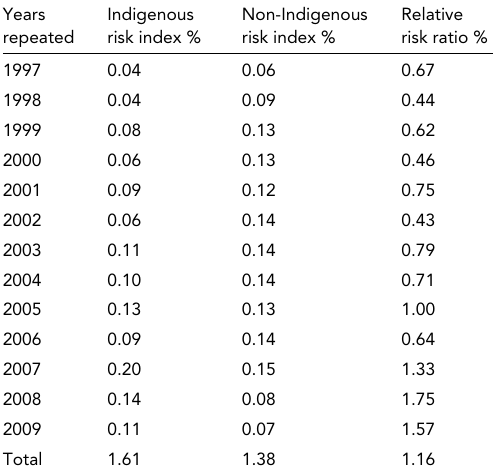
Relative Risk Ratios Calculated From the Risk Ratios of Both Indigenous and Non-Indigenous Repeated